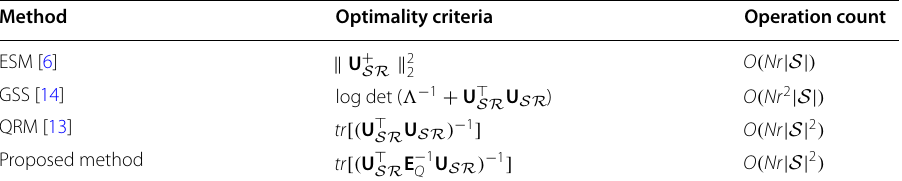
Table 1 Complexity comparison for various sampling methods